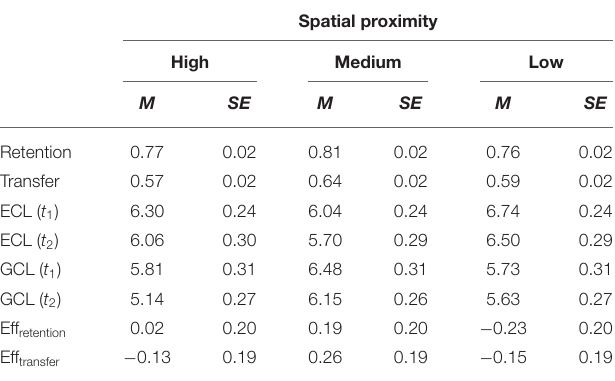
TABLE 2 | Descriptive data for all measures of Experiment